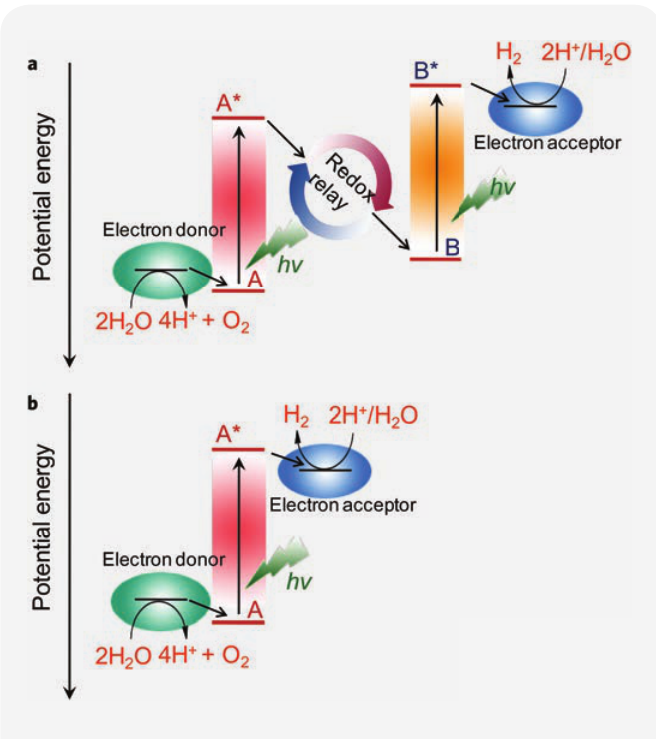
Figure 2. Schematic representation of mechanism of (a) two-step and (b) one-step water splitting. Reproduced with permission from Ref. 3. Copyright 2015, Wiley-VCH Verlag GmbH & Co. KGaA,